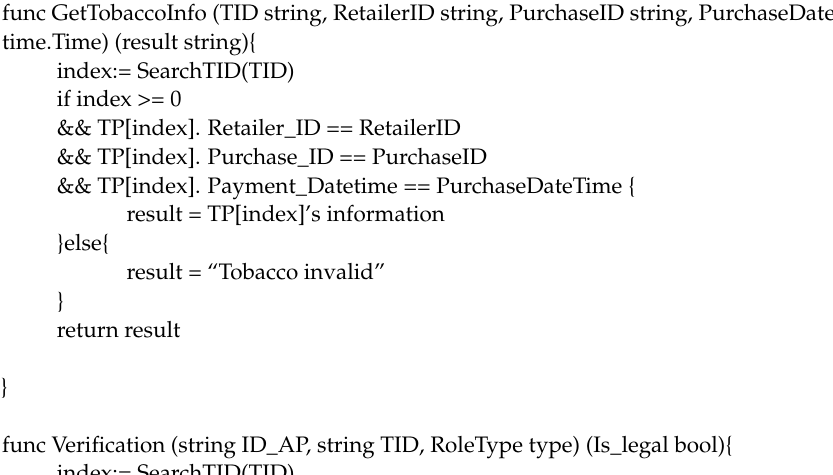
Algorithm 6. Chaincode verification of the proposed